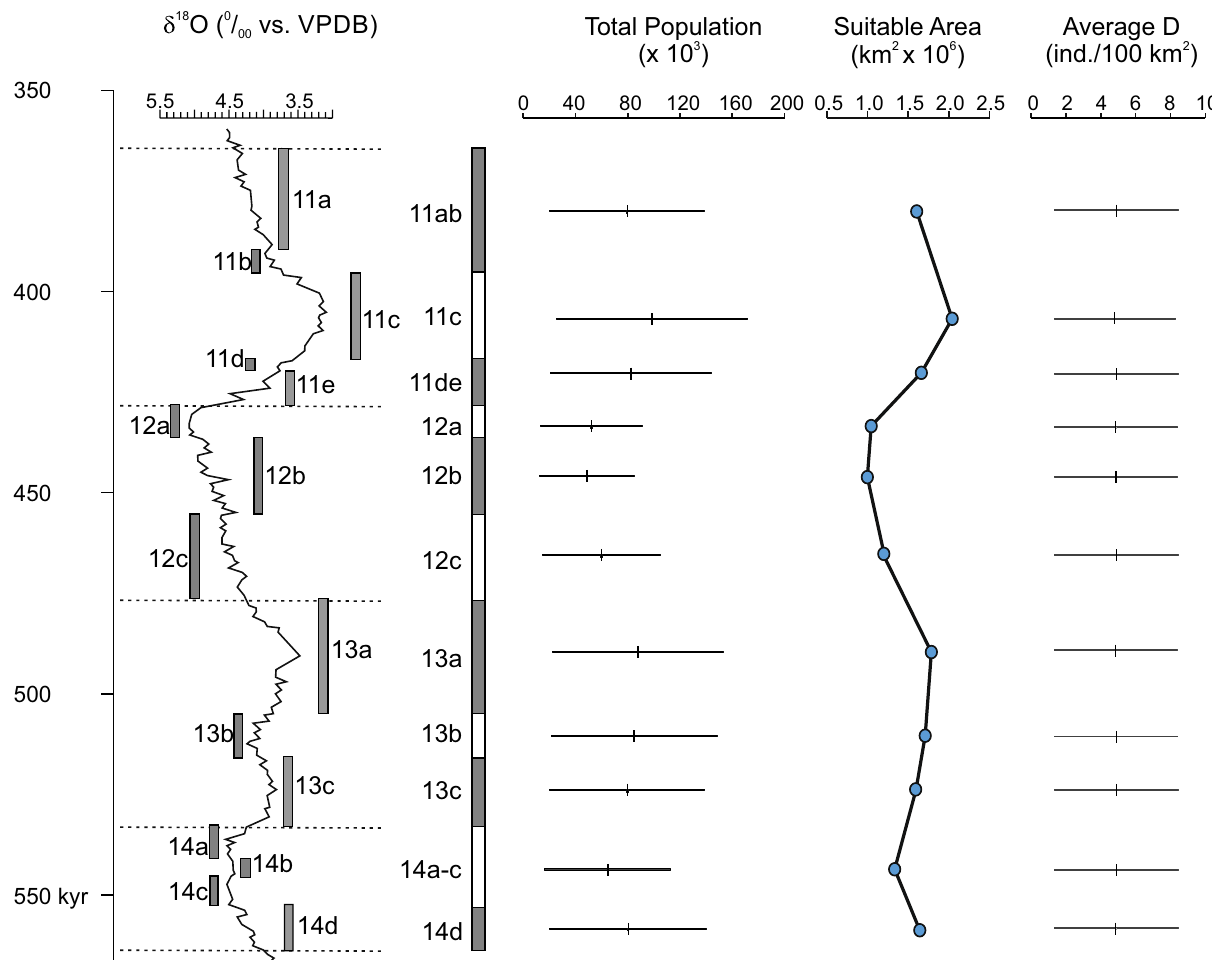
Figure 6. Changes in average population density (D), total population and suitable area in Western Europe during the MIS14-MIS11 period. The LR04 stack of marine benthic foraminiferal δ 18 O 46 is shown as a proxy for climate variation, indicating the substages defined for the MIS14–MIS11 period 24